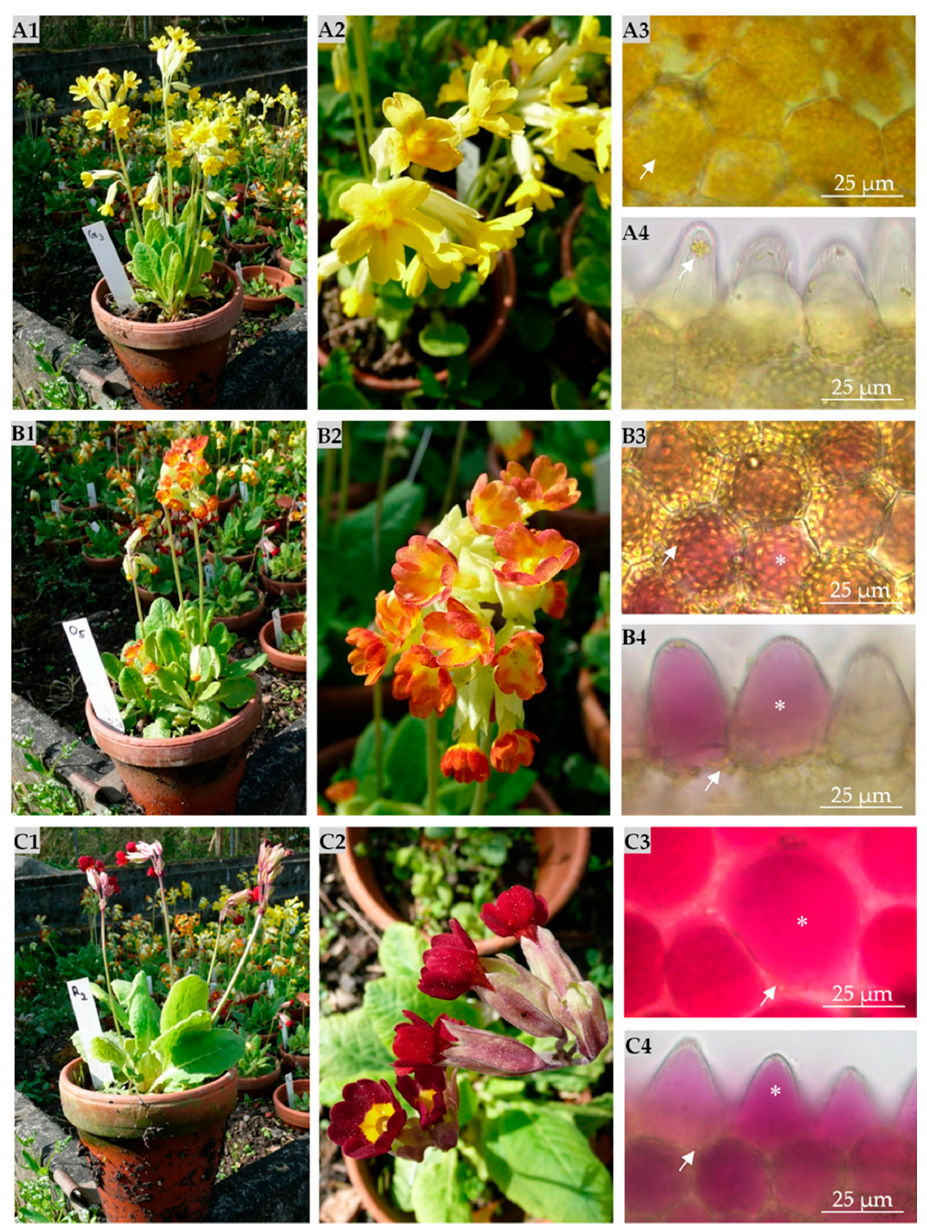
Figure 1. Primula veris L. with different petal colors from the botanical garden of Hohenheim University, May 2015. Overview of P. veris with yellow petals ( A1 ), orange petals ( B1 ) and red petals ( C1 ). Close-up view of the yellow petals ( A2 ), orange petals ( B2 ) and red petals ( C2 ). Light microscopic images of the differently colored petals in supervision ( A3 , B3 , C3 ) and in cross-section ( A4 , B4 , C4 ). Yellow chromoplasts (arrows) are shown in the papilliform epidermis cells of the yellow petals. The vacuoles of the cells are colorless ( A3 , A4 ). The orange colored petals also have yellow chromoplasts. Papillate epidermal cells are characterized by the occurrence of anthocyanins in vacuoles ( B3 , B4 ). Some epidermis cells include anthocyanins ( * ) in their vacuoles, thus exhibiting red color. All papilliform epidermis cells of the red-colored petals have anthocyanin-containing vacuoles. Yellow chromoplasts ( arrows ) exist, but are masked by the content of the vacuoles ( C3 , C4 ).